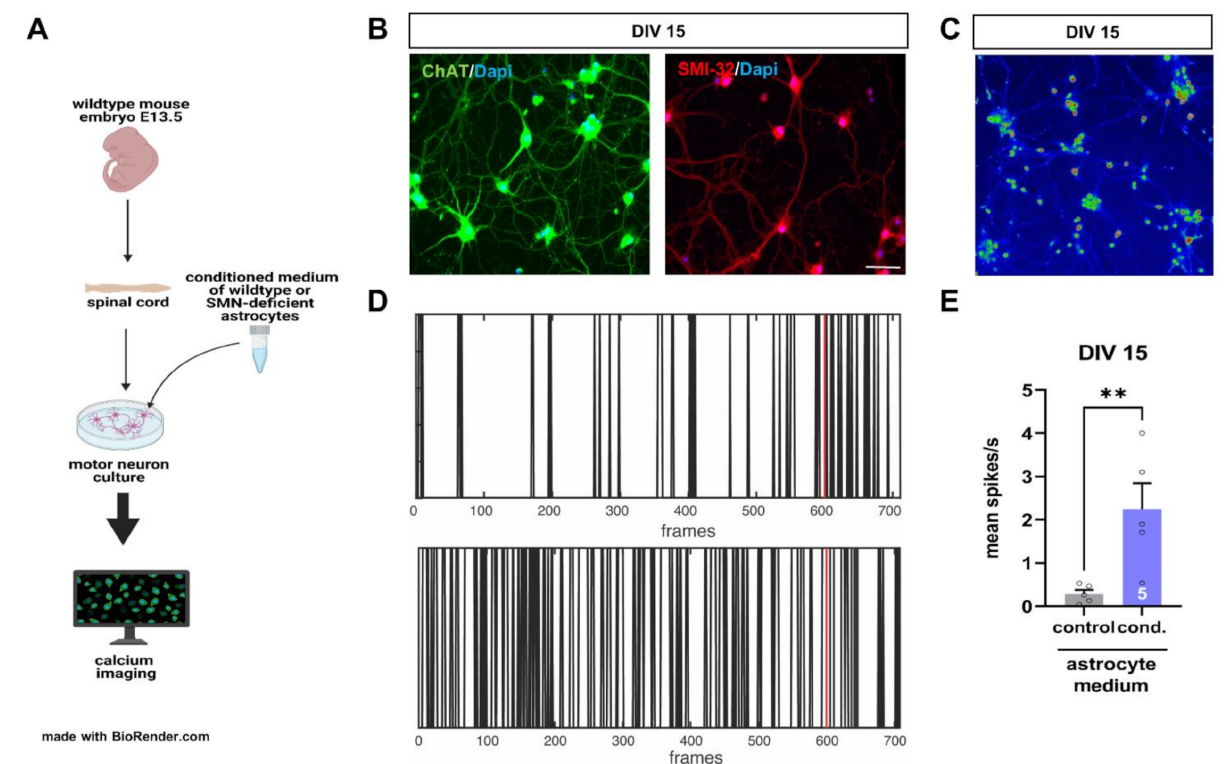
Figure 6. Conditioned medium of SMN-deficient astrocytes leads to hyperactivity of cultured spinal motor neurons of wild-type mice. ( A ) Schematic drawing of experimental design. Motor neurons were isolated from E13.5 embryos of wild-type mice. Cultured motor neurons were exposed to a conditioned medium of astrocytes transfected with scrambled or SMN siRNA for 24 h. Afterward, calcium imaging measurements were performed. ( B ) Immunostaining of cultured motor neurons at DIV 15. Neurons expressed typical markers of motor neurons such as ChAT (green) or SMN-32 (red). In addition, nuclear DNA was stained with Dapi (blue). ( C ) Image with Fluo-4 AM stained motoneurons at DIV 15 in LUT (16 colors). ( D ) Image of spiking events over the recording period. The red line indicates the application of potassium pulse (60 mM KCl). ( E ) Motor neurons exposed to a conditioned medium of SMN-deficient astrocytes showed an increased number in their spiking frequency (**, p < 0.01). n = 5 motor neurons measured per experiment (see bars). Scale bar: 20 µ